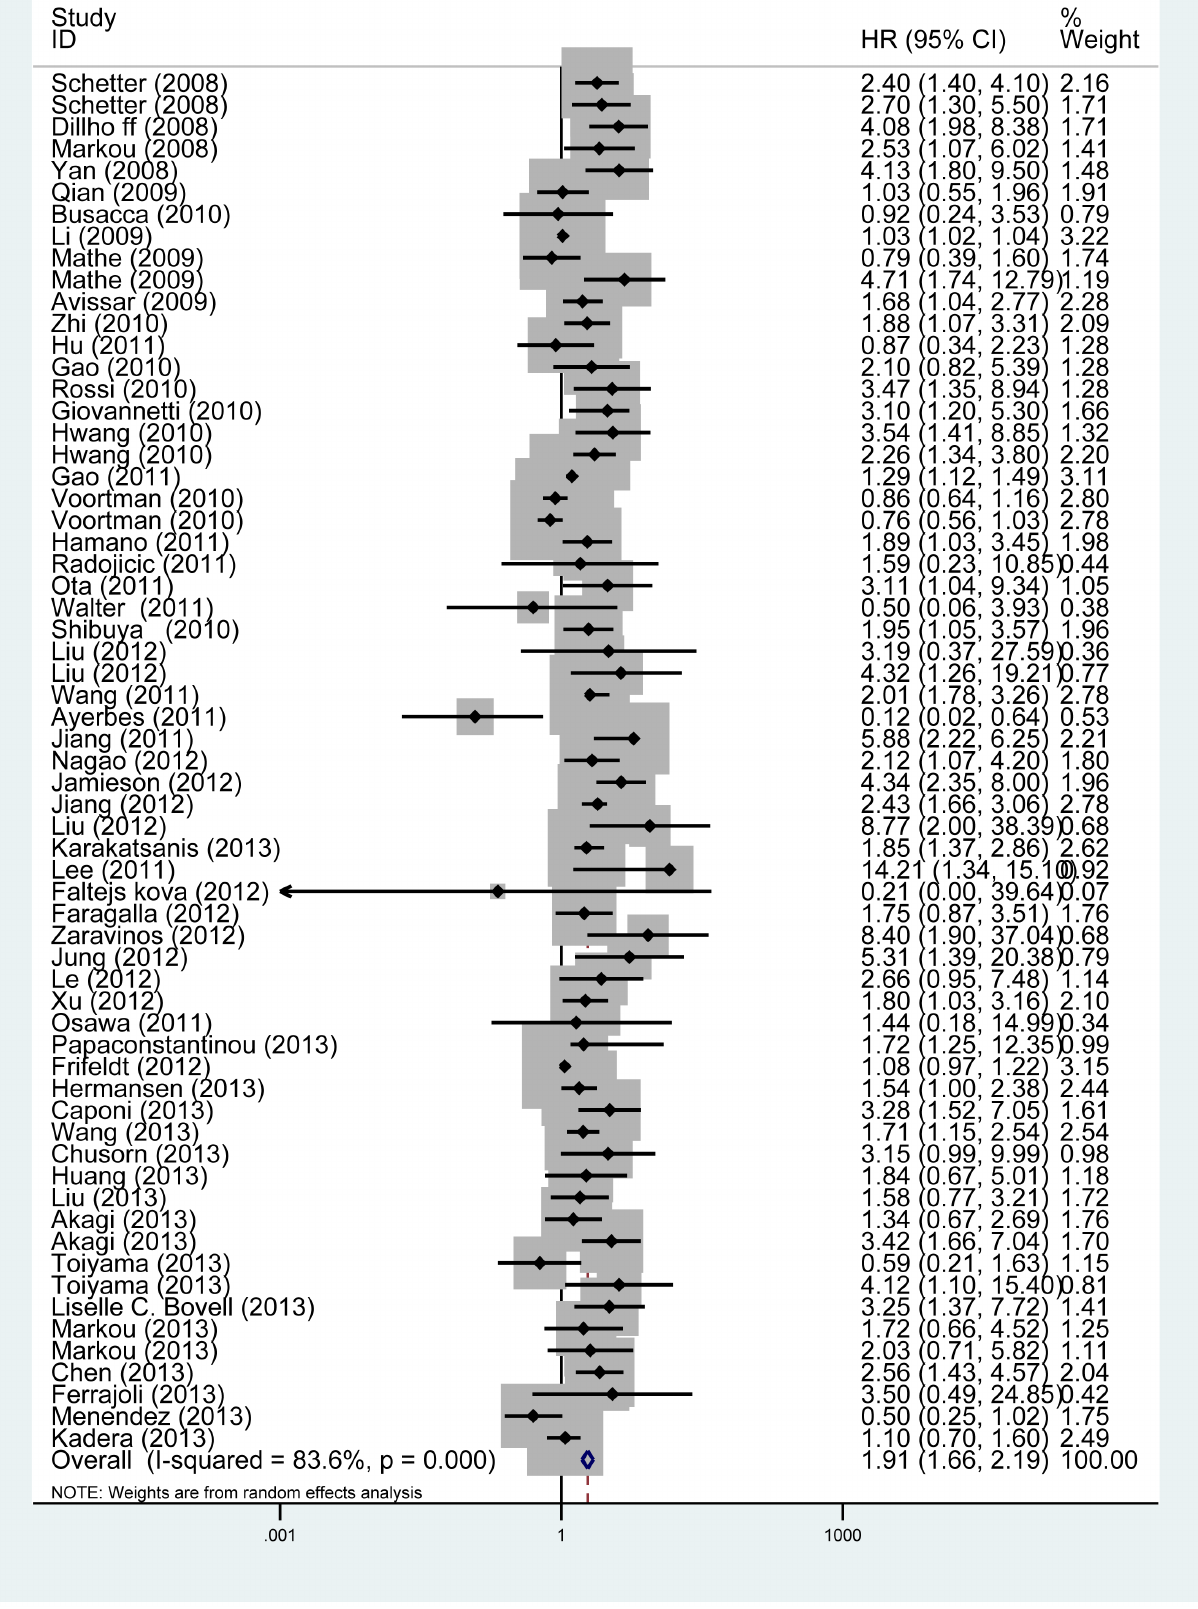
Figure 2. Forrest plots of studies evaluating hazard ratios (HRs) of miR-21 for overall survival. doi:10.1371/journal.pone.0102413.g002 PLOS ONE |